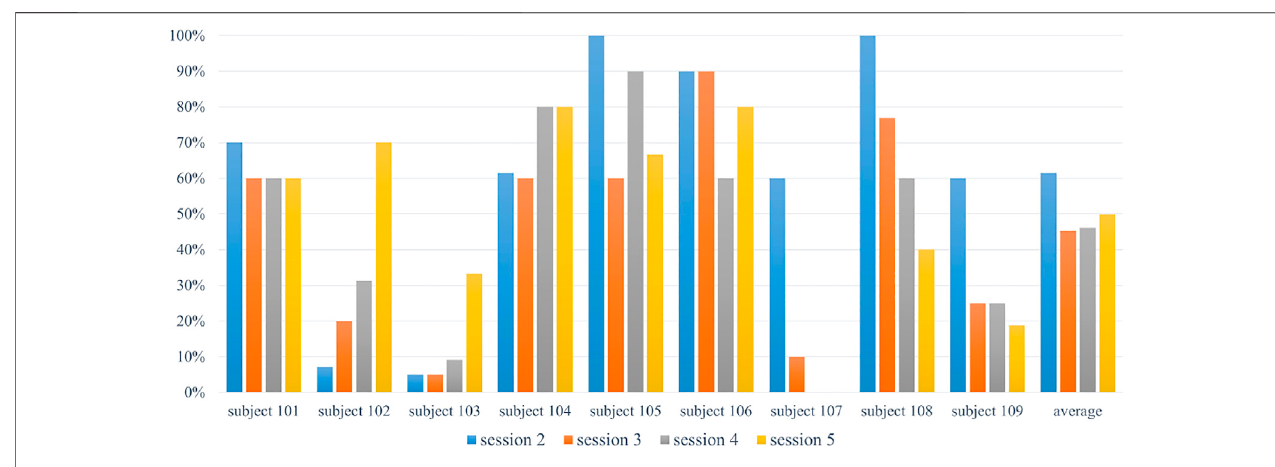
FIGURE 10 | Main music therapy performance